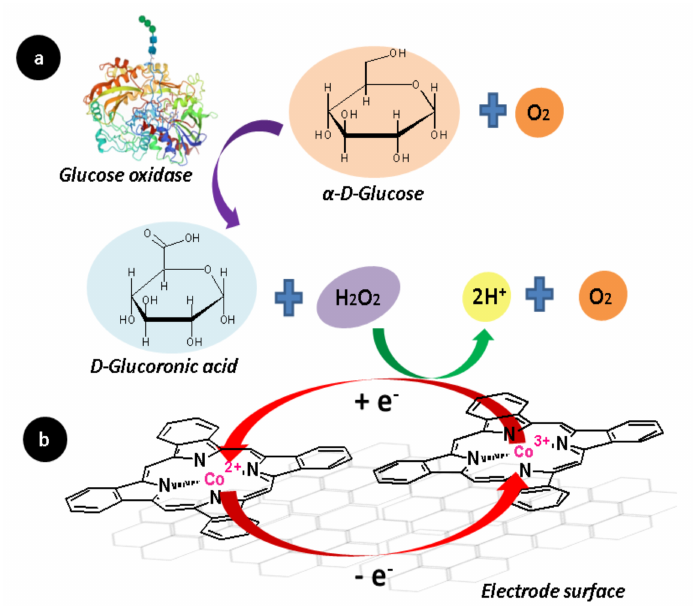
Figure 8. Basic working of an integrated bio-electrode: ( a ) The GOx enzyme catalyzes the oxidation of glucose and generates hydrogen peroxide as a by-product. ( b ) Then, the hydrogen peroxide is electro-oxidized by the metal center of the complex, and the electron exchange of the reaction is used in an electroanalytical technique to quantify the amount of glucose in a